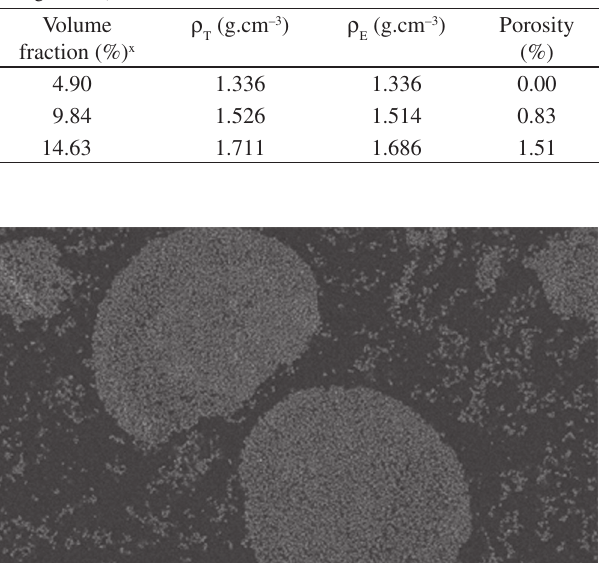
) and experimental ( ρ ) density and calculated T E